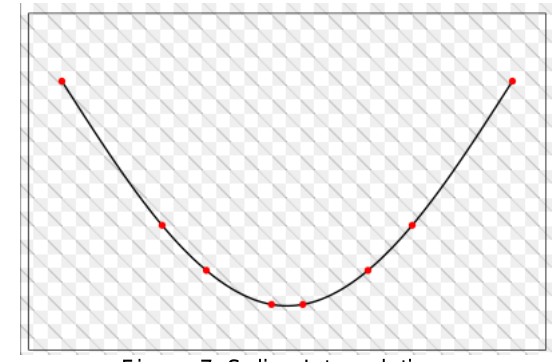
Figure 7: Spline Interpolation